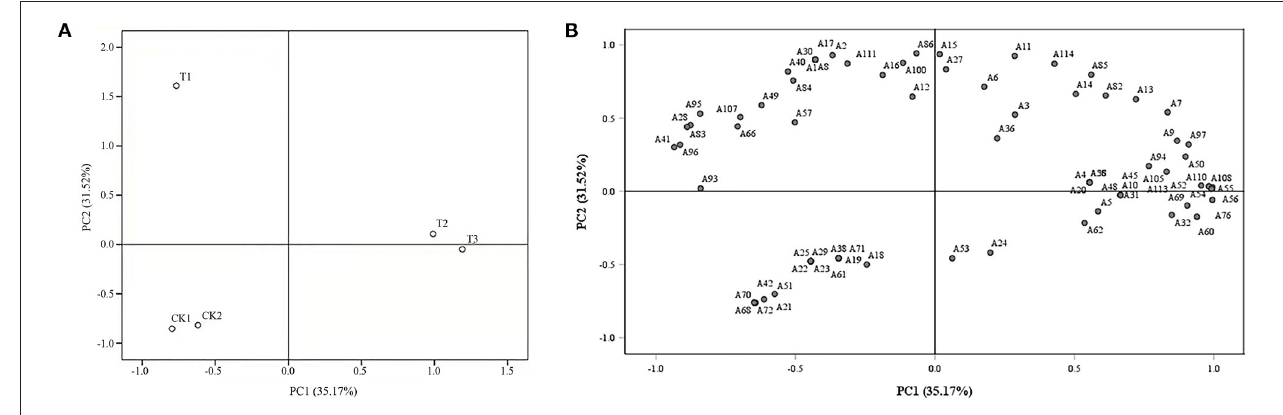
FIGURE 6 | Principal component analysis (PCA) of loose-curd cauliflower heads and 115 volatile compounds. (A) shows the PCA loading plot, whereas (B) shows the PCA scatter plot. The number code after “A” in (B) also corresponds to the relevant volatile code in Table 4